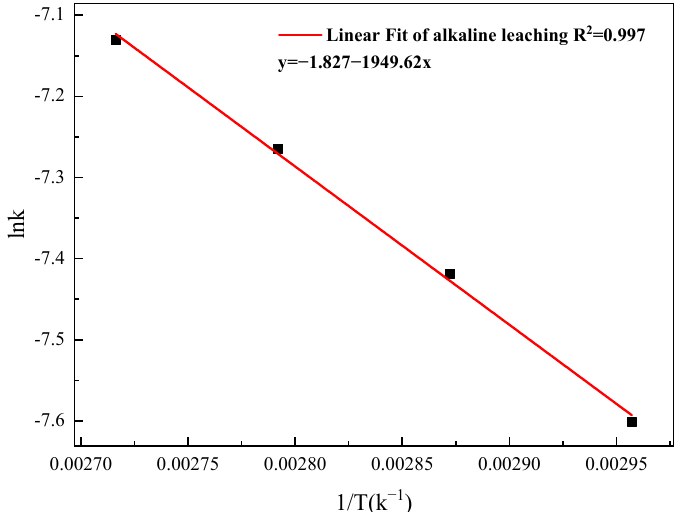
Figure 9. Plots of lnk versus 1/T of the Al 2 O 3 leaching rate.